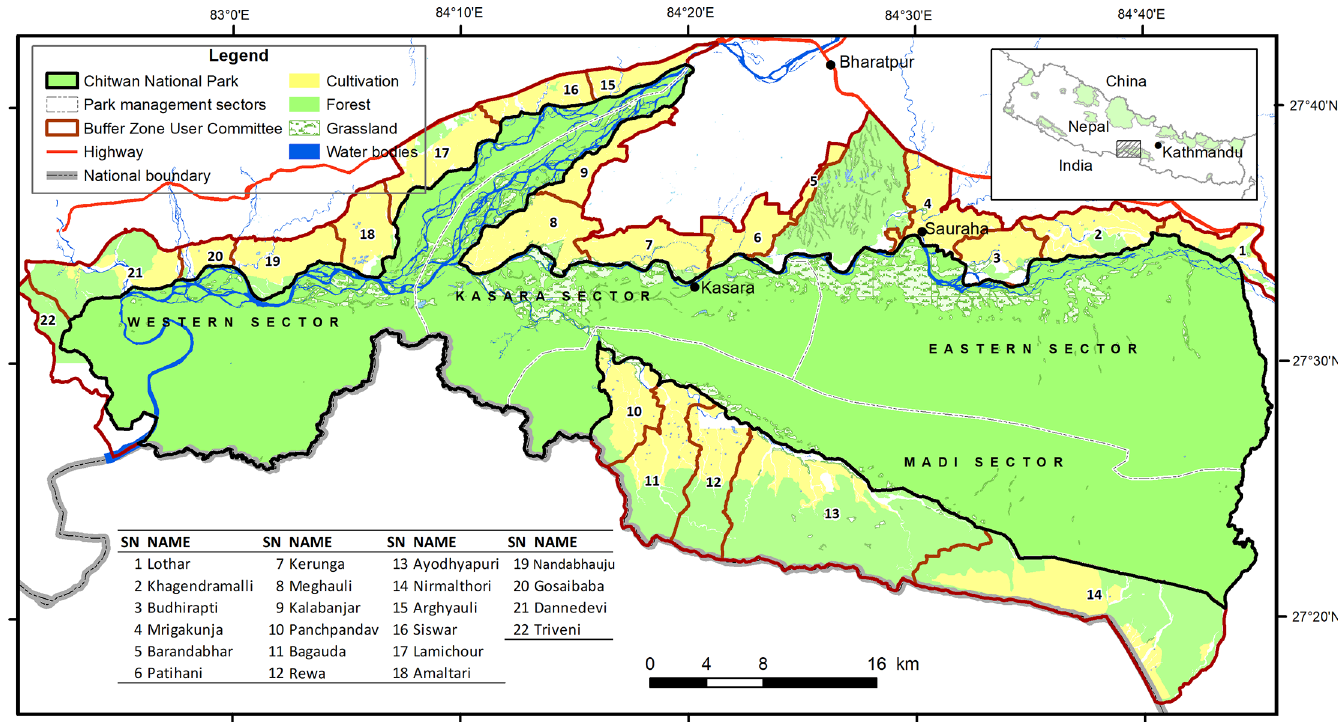
Fig 1. Chitwan National Park and buffer zone area, showing the land cover and management sectors. The labels (1–22) represents the Buffer Zone User Committees (BZUC) and the table (top left) gives the names of respective BZUC.